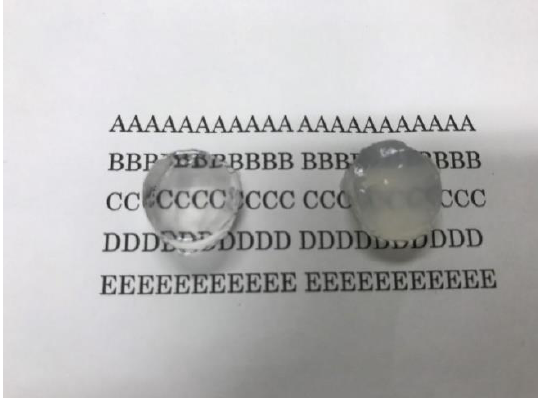
Figure 3. Representative compressive stress–strain curves for 10 wt % laponite/PAAS and 10 wt % sumecton/PAAS blend hydrogels.